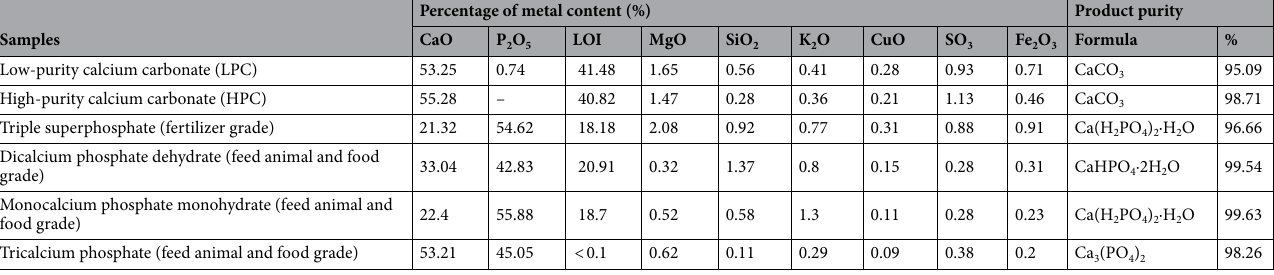
Table 1. Compositions (± 0.02%) of starting agents (CaCO 3 obtained from eggshells) and as determined by X-ray fluorescence (XRF). Percentage values less than 0.02% (limit of detection) were omitted for